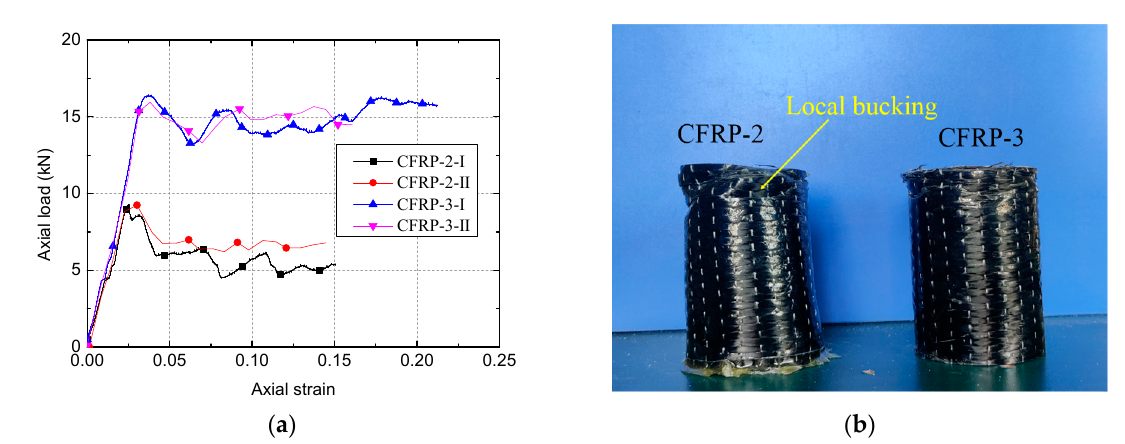
Figure 4. Two specimens with 2 CFRP layers (CFRP-2-I and -II) and two specimens with 3 layers (CFRP-3-I and -II) were tested: ( a ) Load–strain curve; ( b ) Failure mode of CFRP tube.